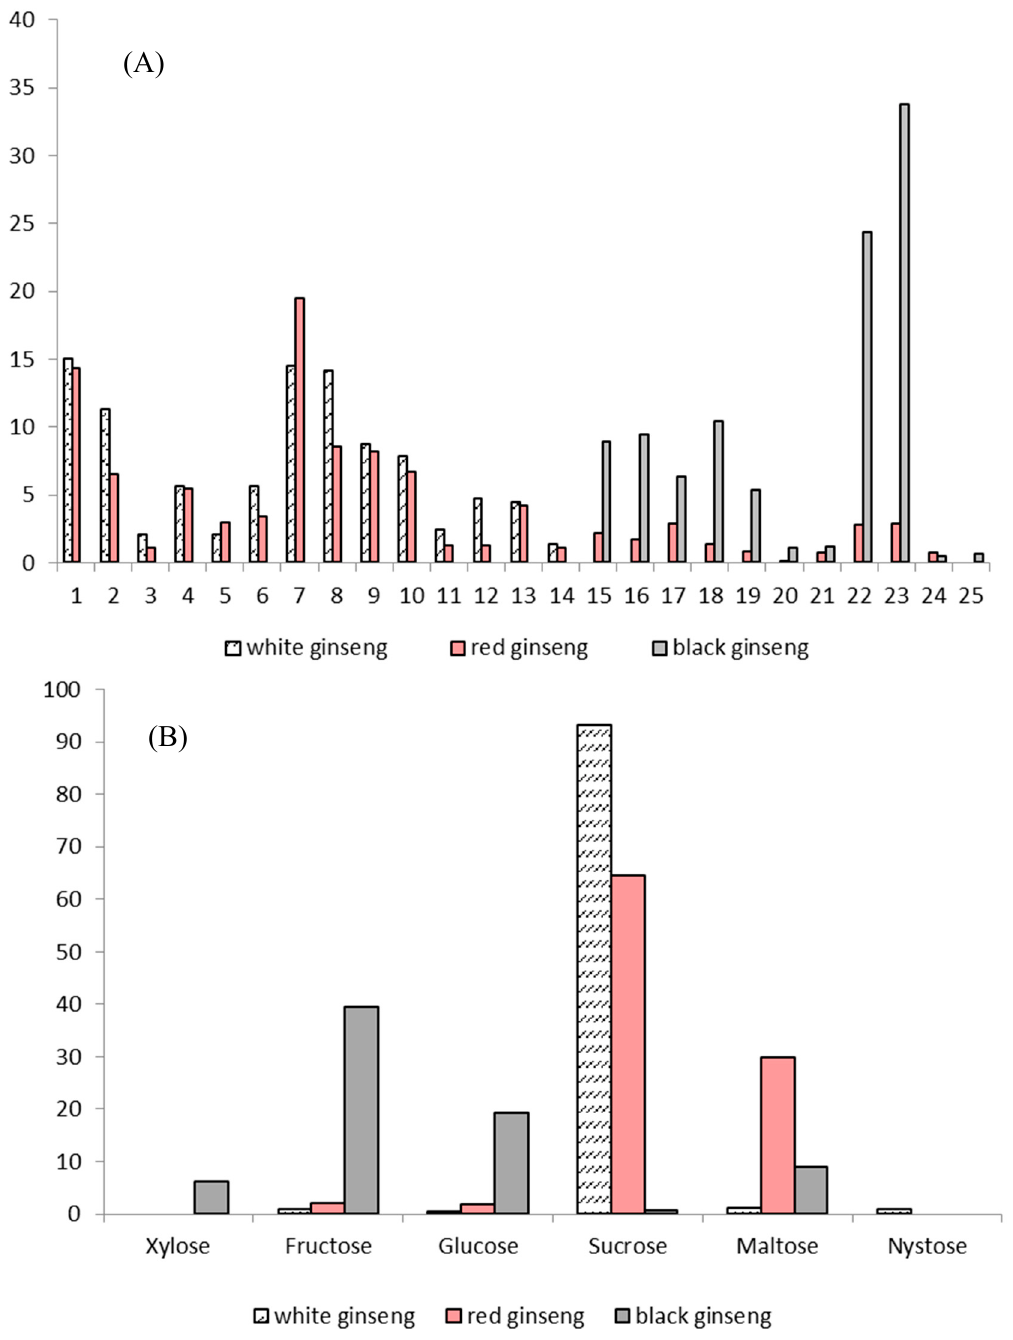
Figure 5. The relative percentage of individual ginsenosides ( A ) and oligosaccharides ( B ) in white P. ginseng , red P. ginseng and black P. ginseng . Note: 1-Rg 1 ; 2-Re; 4-Rf; 5-(S)-Rg 2 ; 6-(R)-Rg 2 ; 7-Rb 1 ; 8-Rc; 9-Ro; 11-Rb 2 ; 12-Rb 3 ; 13-Rd; 18-(S)-Rg 3 ; 19-(R)-Rg 3 ; 20-(S)-Rs 3 ; 21-(R)-Rs 3 ; 22-Rk 1 ; 23-Rg 5 ; 24-(S)-Rh 2 ; 25-(R)-Rh 2 .